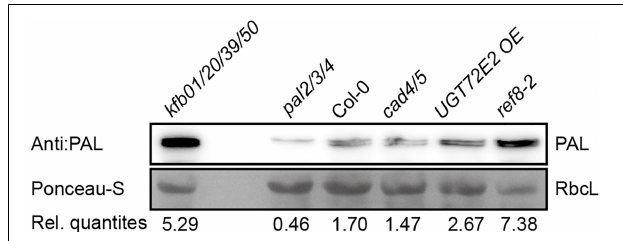
FIGURE 6 | The protein level of PAL is increased in ref8-2 and UGT72E2 OE seedlings. The protein level of endogenous PAL in 2-week-old Col-0, cad4/5 , UGT72E2 OE and ref8-2 seedlings. Endogenous PAL content was normalized to the content of RbcL by Ponceau S staining, and relative quantities (Rel. quantities) represent the ratio of the intensity of PAL relative to the corresponding RbcL